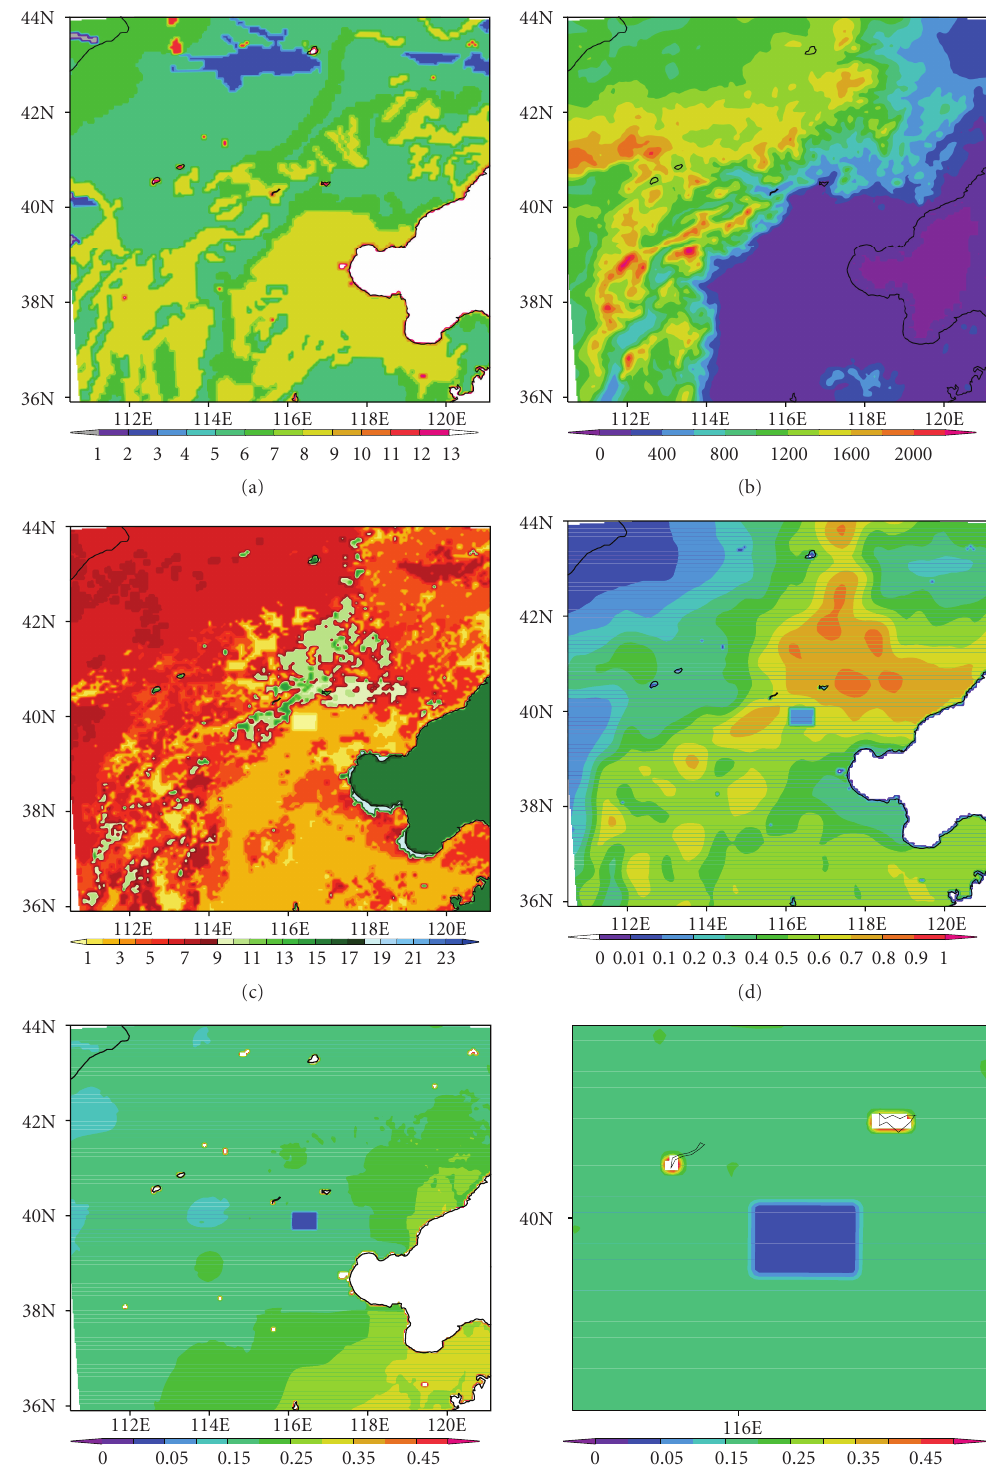
Figure 7: The land surface properties of the study domain in WRF: (a) soil category, (b) terrain height, (c) land use category, (d) green vegetation fraction (GVF), (e) soil moisture at the first soil layer (5 cm) for domain 2, and (f) the same as (e) but for analysis